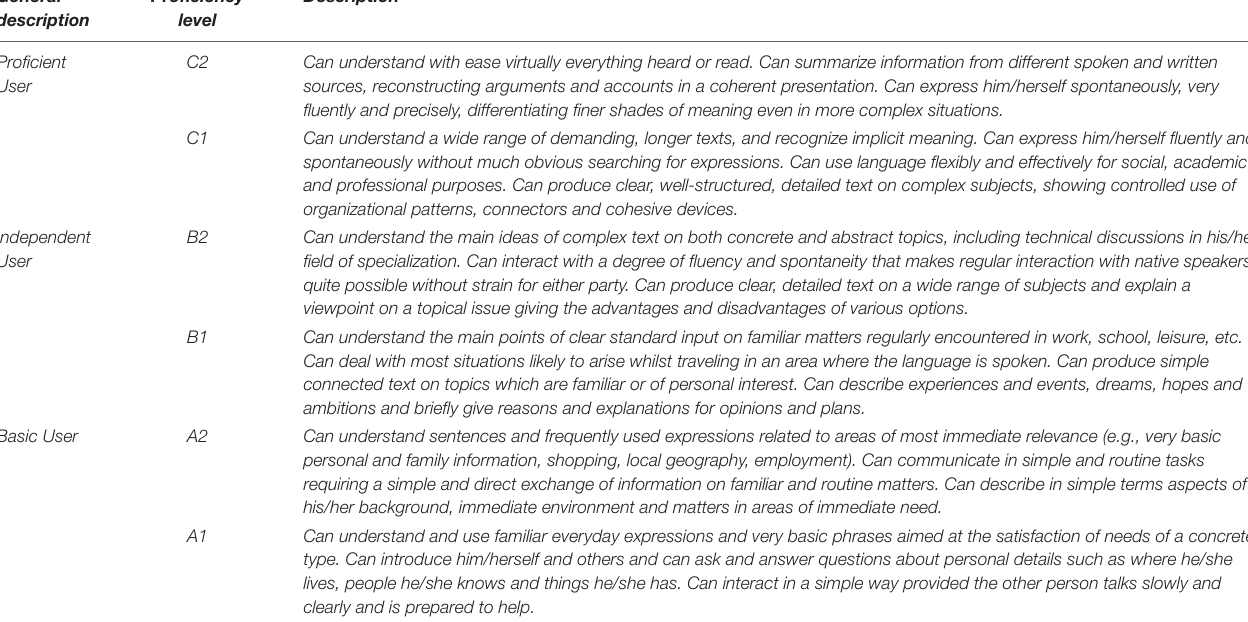
TABLE 1 | Common European Framework of References (CEFR) proficiency level descriptions.